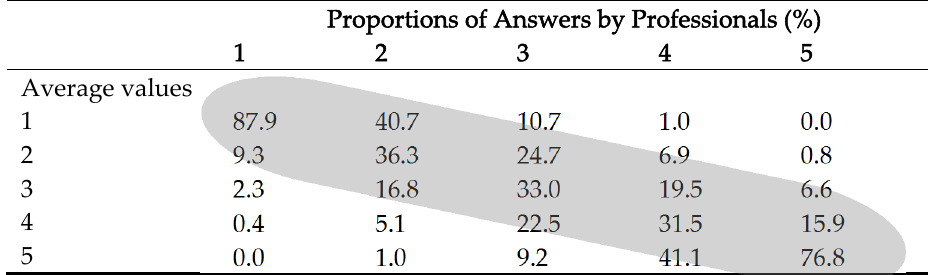
Table 2. Need for pre-harvest clearing of understory trees in five classes based on the e-questionnaire survey mean field data values versus values estimated from the airborne laser scanning (ALS) linear discriminant analysis